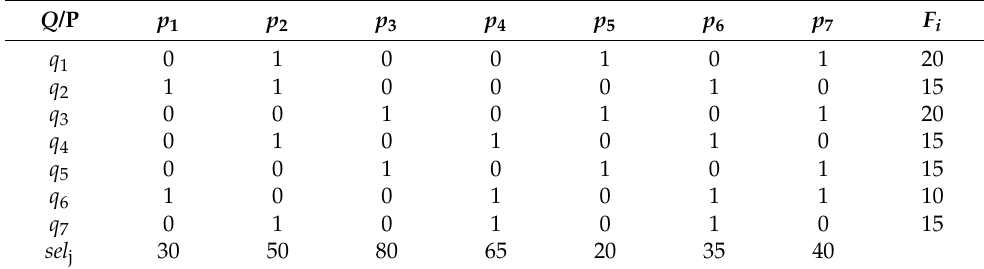
Table 16. Predicate use matrix for the third experiment.